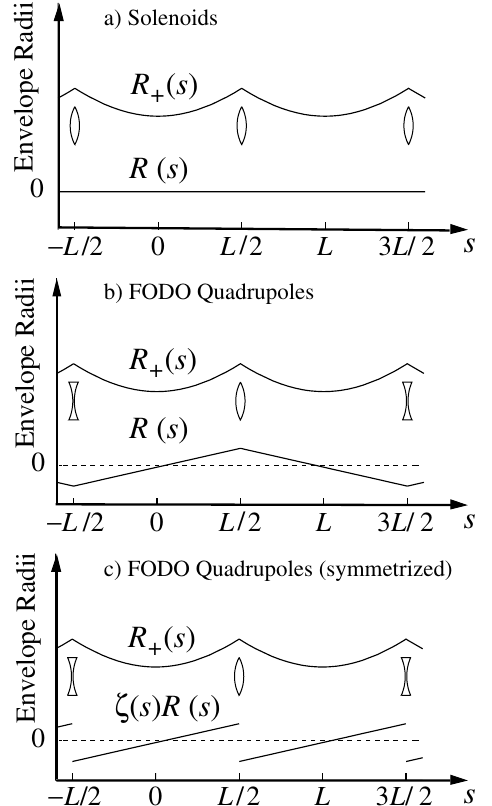
FIG. 24. Matched beam envelopes R (cid:16) (cid:3) s (cid:4) and transport lattice for (a) solenoid and (b) FODO quadrupole thin-lens trans- port channels. In (c), < (cid:3) s (cid:4) R (cid:2) (cid:3) s (cid:4) is plotted for the quadrupole